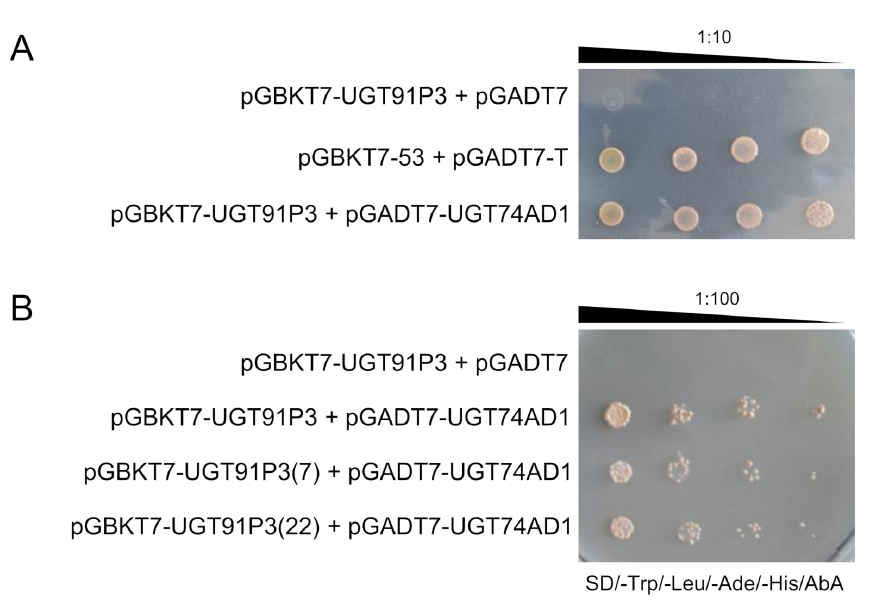
Figure 5. Interaction between UGT91P3 and UGT74AD1 in yeast by two-hybrid (Y2H) analyses. ( A ) Serial dilutions of diploid yeast cells containing different constructs were spotted on selective media, and incubated for two days at 30 ◦ C. The image is representative of four independent experi- ments, each with 3 different clones analyzed. ( B ) Serial dilutions of diploid yeast cells containing UGT91P3 and the other two alleles (7 and 22) were spotted on selective media, and incubated for two days at 30 ◦ C. The image is representative of four independent experiments, each with 3 different clones